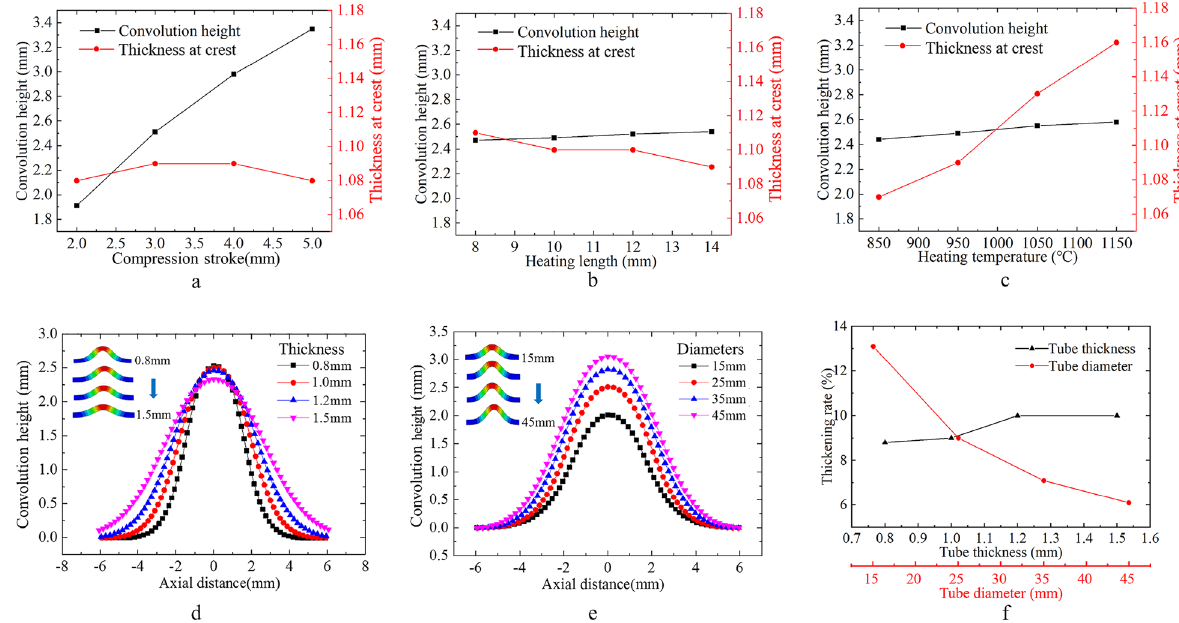
Figure 8 Curves of convolution profile at: a different compression strokes, b different heating lengths, c different heating temperatures, d different initial tube wall thicknesses, e different tube diameters, and f thickening rate at different geometric